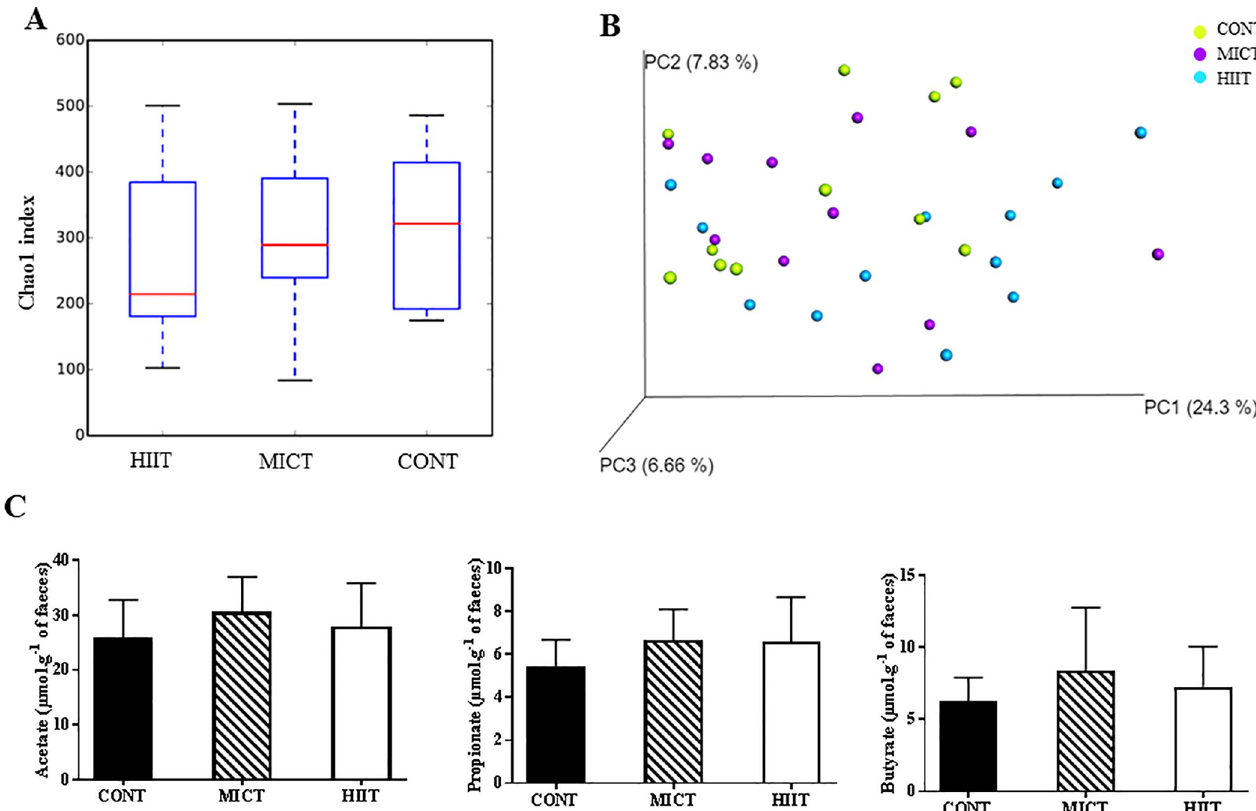
Fig 3. Effect of 10 weeks of exercise training on gut microbiota and faecal concentration of short-chain fatty acids (SCFAs). Gut microbiota composition: Chao1 index (A); Principal Component Analysis (PCoA) of the Bray-Curtis distances ( β -diversity) (B); SCFA concentration in faeces after 10 weeks of training (C). Data are expressed as the mean ±